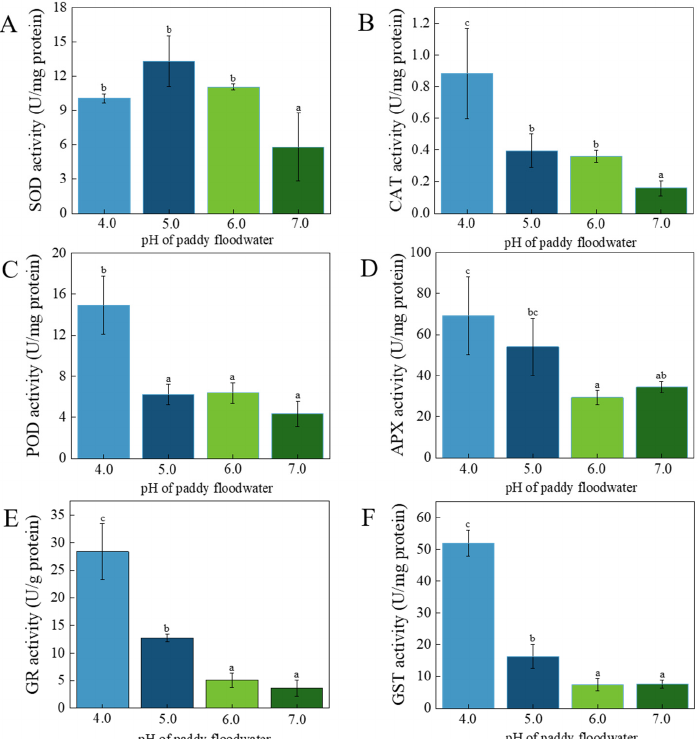
Figure 6. Effects of paddy floodwater acidification on activities of SOD ( A ), CAT ( B ), POD ( C ), APX ( D ), GR ( E ), and GST ( F ) in the cells of Aliinostoc sp. YYLX235. Different letters indicate statistically significant at p < 0.05 (one-way ANOVA, LSD).